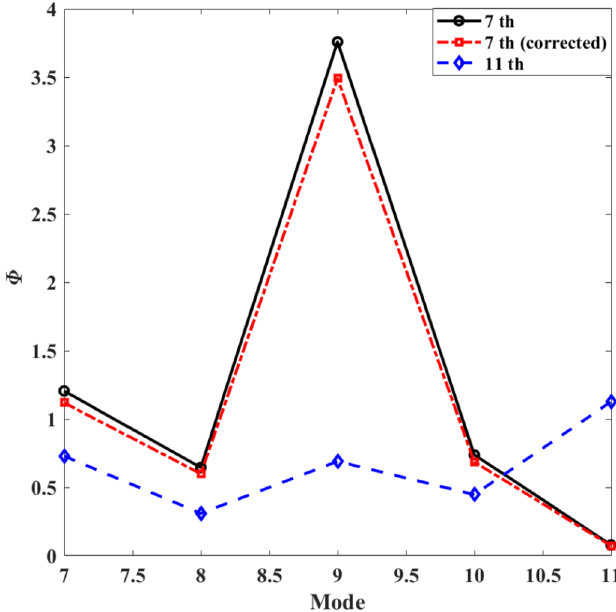
Fig. 9. Optimal result of optical fi ber sensor: the optimal strain vector. Fig. 10. Fiber optimization result: optimal strain